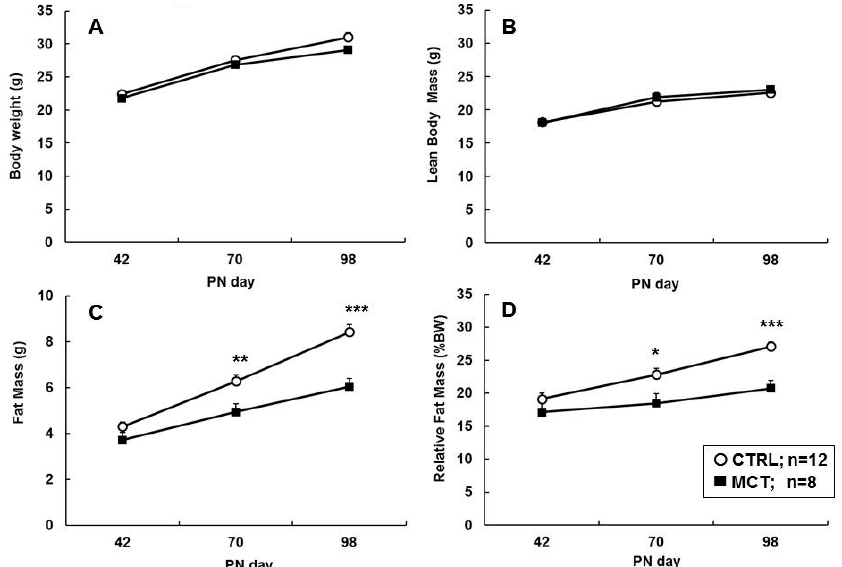
Figure 2. Mouse study Development of body weight (BW), lean body mass (LBM), fat mass (FM), and relative fat mass (%BW) during the WSD challenge (PN 43–98) of male mice (panels ( A – D ), respectively) fed a CTRL ( n = 12) or MCT diet ( n = 8) in early life (PN day 2–42). Values are means ± SD; * p < 0.05; ** p < 0.01; *** p < 0.001 vs. CTRL.